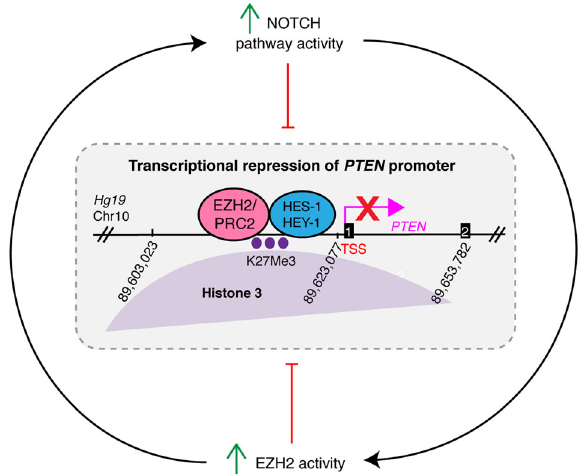
Fig. 6 Model of transcriptional repression of PTEN . The NOTCH and PRC2/EZH2 pathways form a regulatory loop where both can feed into the transcriptional repression of PTEN. Mutation or translocation of NOTCH1 or NOTCH2 leads to upregulation of HES-1/HEY-1 and PRC2/EZH2; however, NOTCH mutation is not required for EZH2 activity or transcriptional repression. EZH2 signaling can also upregulate NOTCH 38 . PRC2/EZH2 adds the H3K27Me3 mark of transcriptional repression (purple dots), and binds with the HES-1 transcription factor on the PTEN promoter leading to repression. Numbers 1 and 2 in black boxes represent exons of PTEN